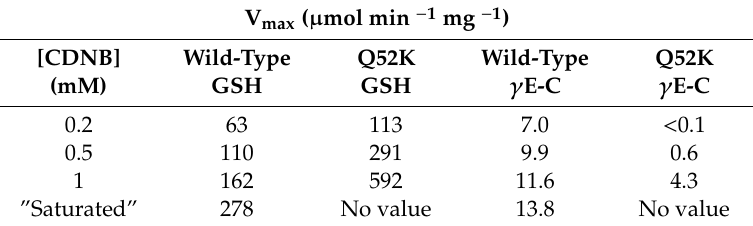
Table 3. Saturation kinetics in three